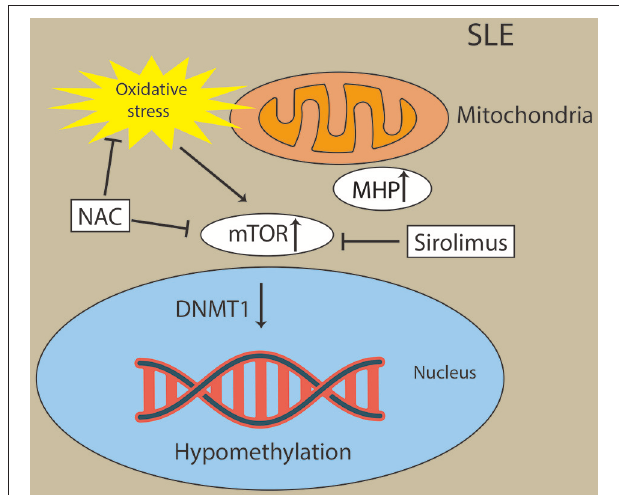
FIGURE 5 | Activation of mTOR and oxidative stress drive Pathogenesis in lupus T cells. Oxidative stress originates from mitochondrial hyperpolarization (MHP) and activated the mTOR pathway in lupus T cells. Oxidative stress and mTOR and contribute to the hypomethylation in lupus T cells through diminishing activity of DNMT1. Sirolimus (a mTOR inhibitor) and NAC (an oxidative stress inhibitor) has been found to block the activity of mTORC1 in lupus T